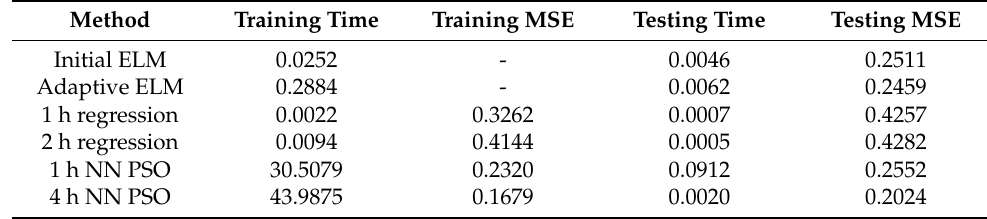
Figure 15. The experimental results of GHI. The predicted results (dots) are read every 15 min and compared to the actual GHI (solid line). Table 3. Comparison of the experimental